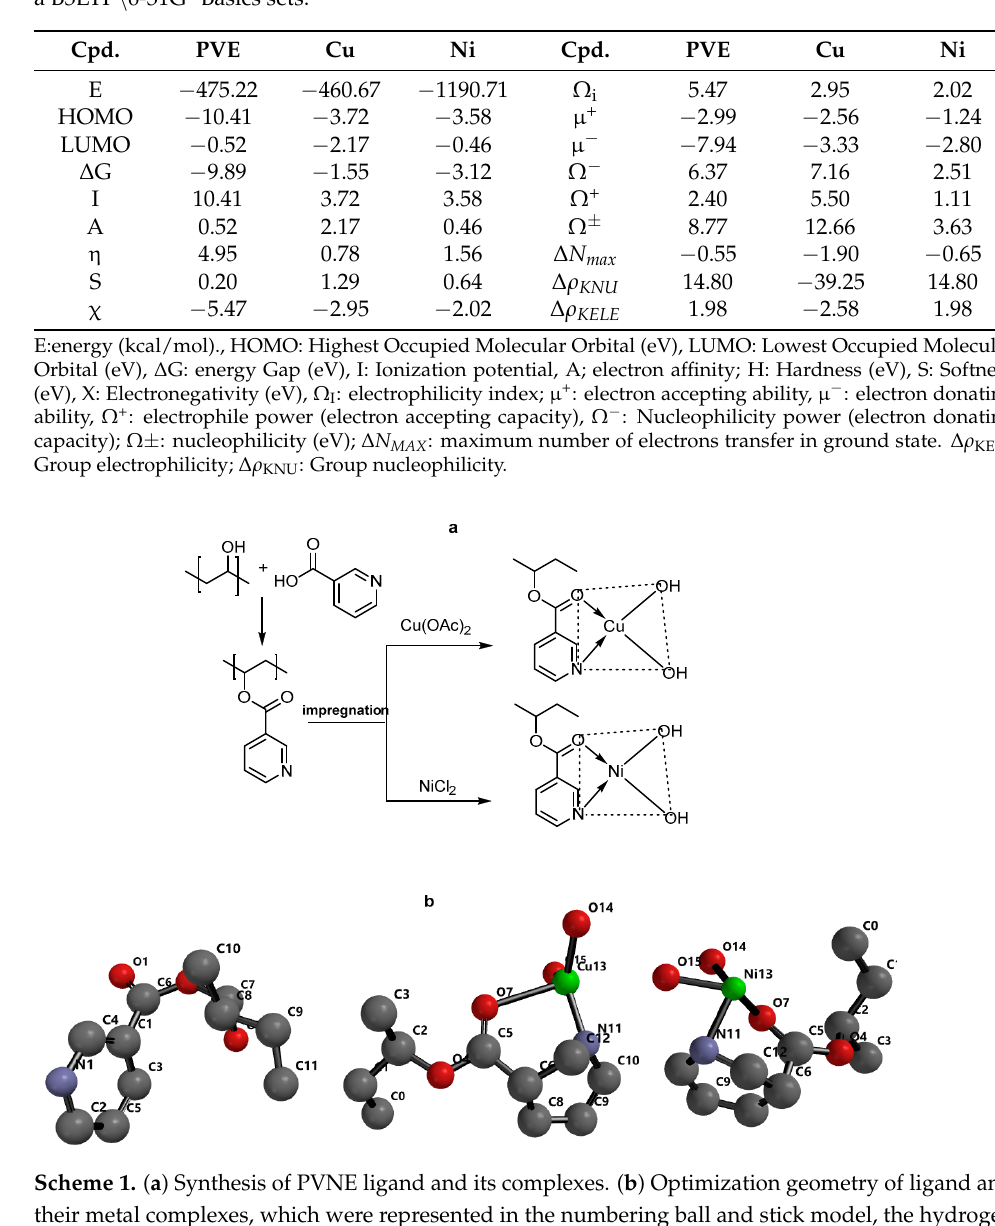
Table 3. Calculated energetic of reactivity parameters for compounds PVE and M II /PVE at DFT with a B3LYP \ 6-31G* Basics